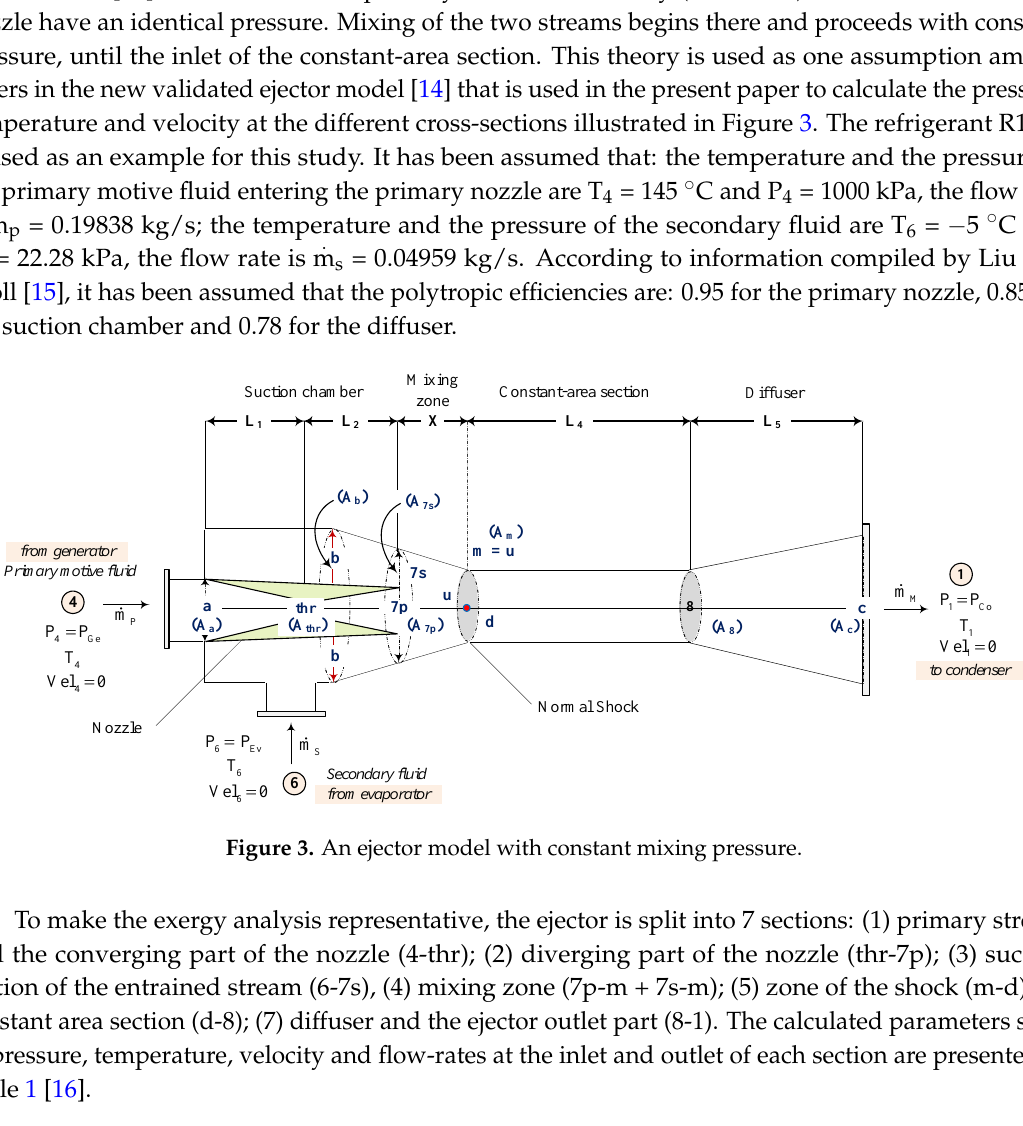
Table 1. Calculated parameters at different ejector’s sections with R141b as working fluid.